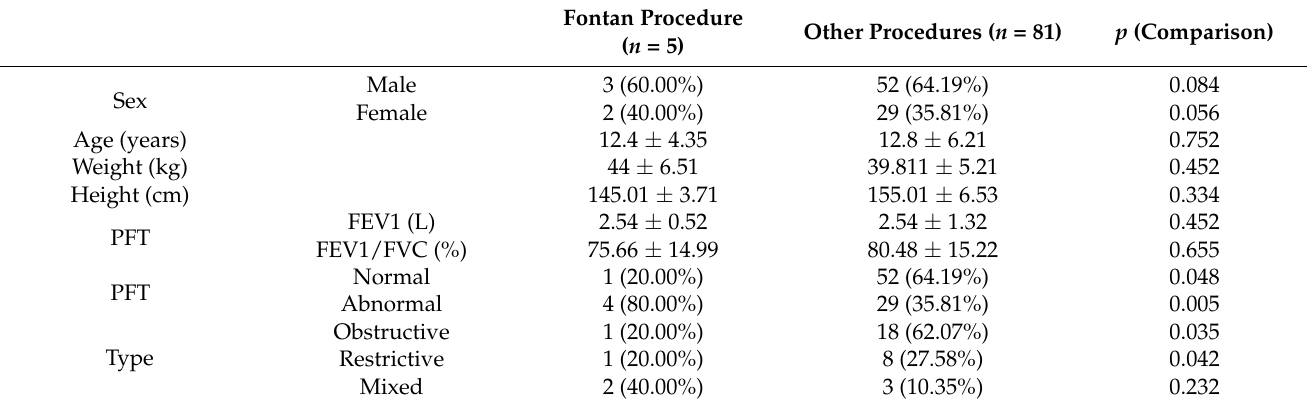
Table 3. Comparison of spirometry data between patients under the Fontan procedure and those under other procedures in our